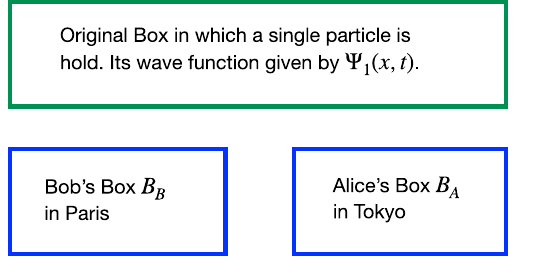
Figure 1. A single particle with wavefunction given by � 1 ( x , t ) is hold in the original Box. After that, the original Box is divide in two Boxes, one of them carried to Paris by Bob and the other one carried to Tokyo by Alice, therefore the wavefunction after the splitting is given by � 2